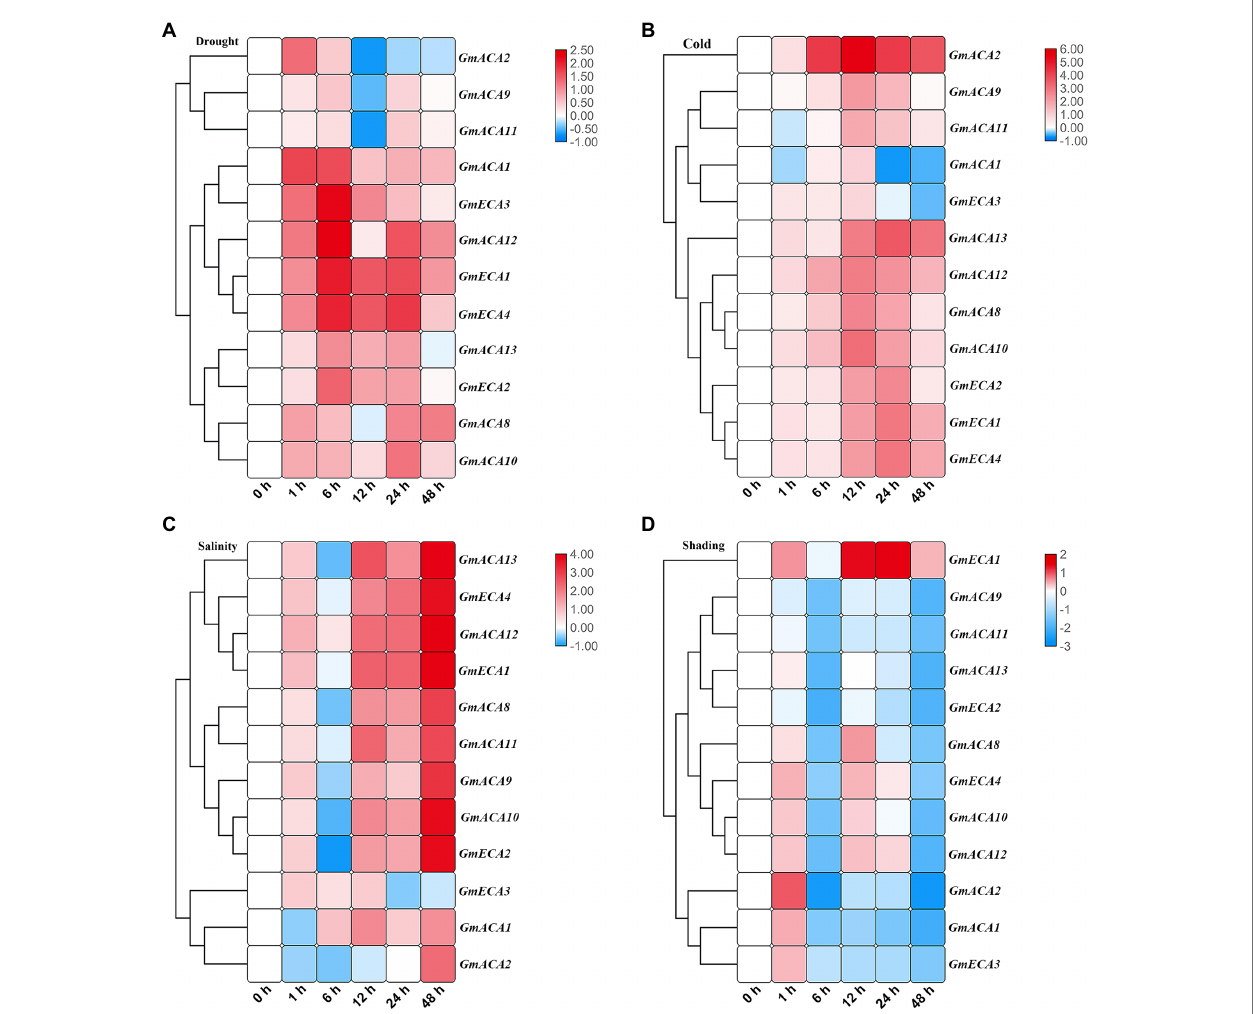
FIGURE 6 | Heat map expression profiles of P 2 -type ATPases genes in leaf under four different abiotic stresses. (A) drought stress; (B) cold (4 ° C); (C) salinity stress (250 mM); (D) shading stress. The color bar in each panel represents log 2 expression values, blue indicates lower and red higher transcript abundance compared to the relevant control. The annotated color quantitation scale is seen as a vertical column on the right side of the heat map. Abiotic stress stages used for expression profiling are mentioned at the bottom of each